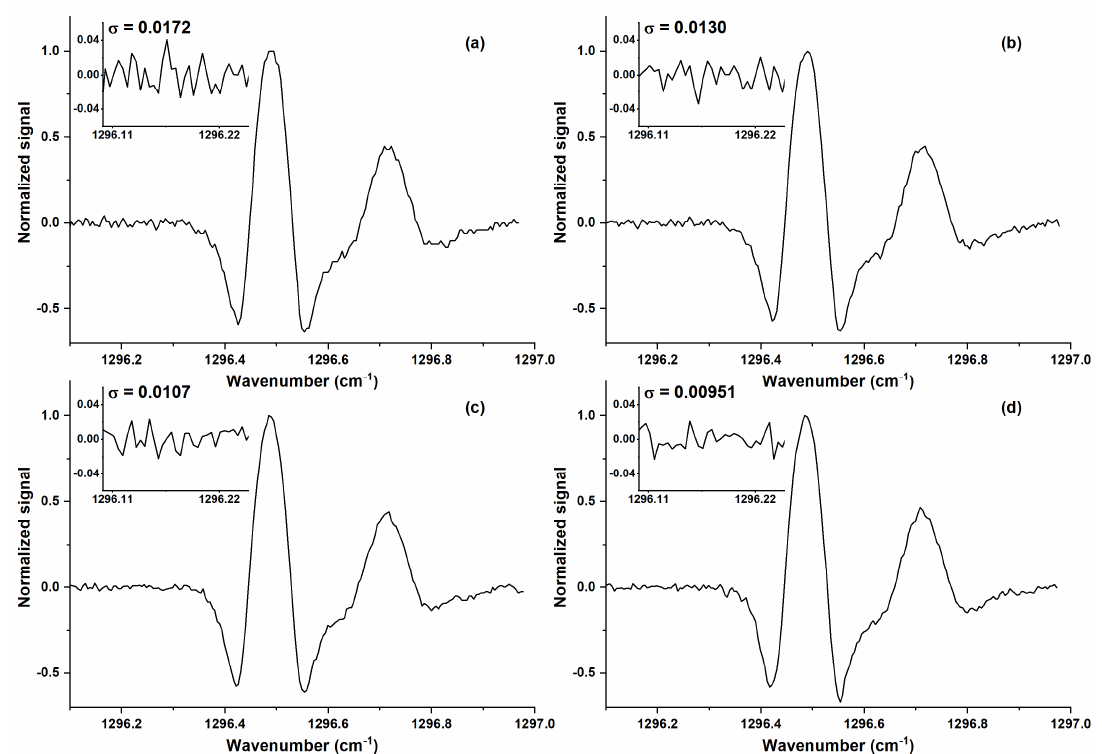
Figure 5. Normalized 2f-QEPAS signals of a mixture containing 2% of water vapor acquired with ( a ) single-ended transimpedance amplifier, ( b ) differential output transimpedance amplifier, ( c ) differential input voltage amplifier and ( d ) fully differential voltage amplifier. In the insets the enlarged views of the noise fluctuations are shown.